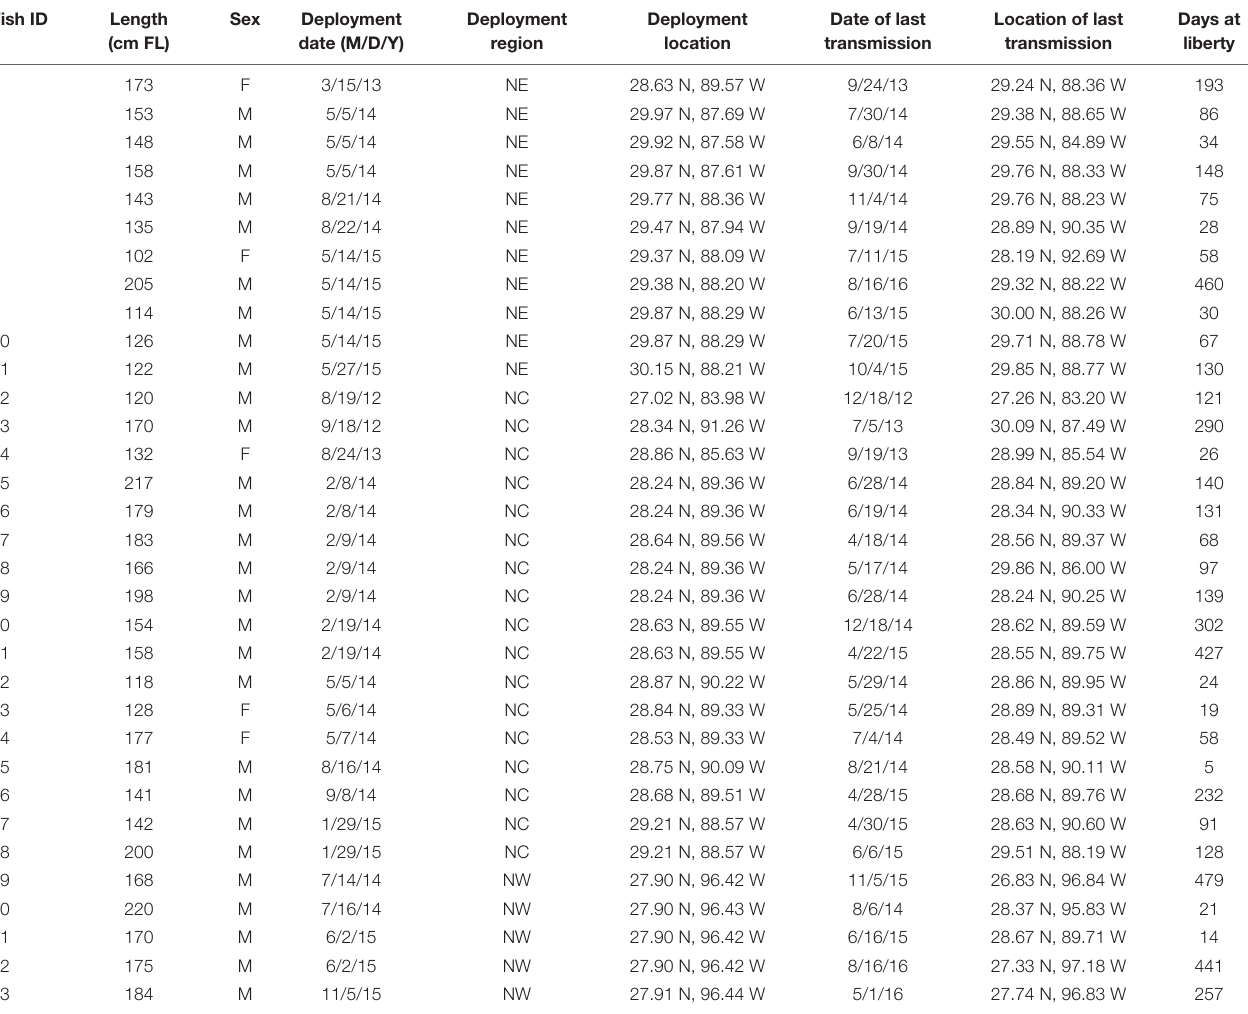
TABLE 1 | Summary information from SPOT tag deployments on scalloped hammerheads in the Gulf of Mexico. Fish